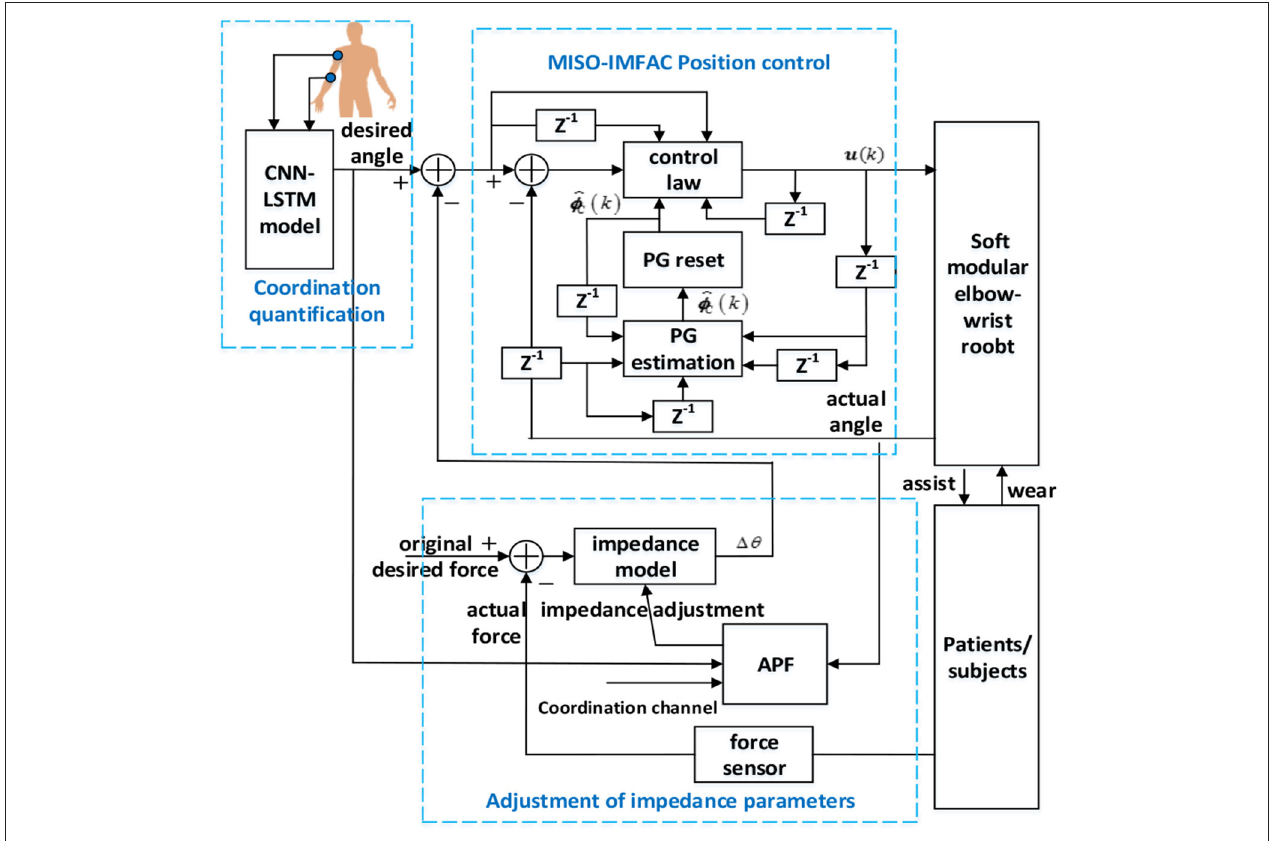
FIGURE 8 | Diagram of the proposed coordinated controller with the coordination quantification, impedance adjustment, and position control.